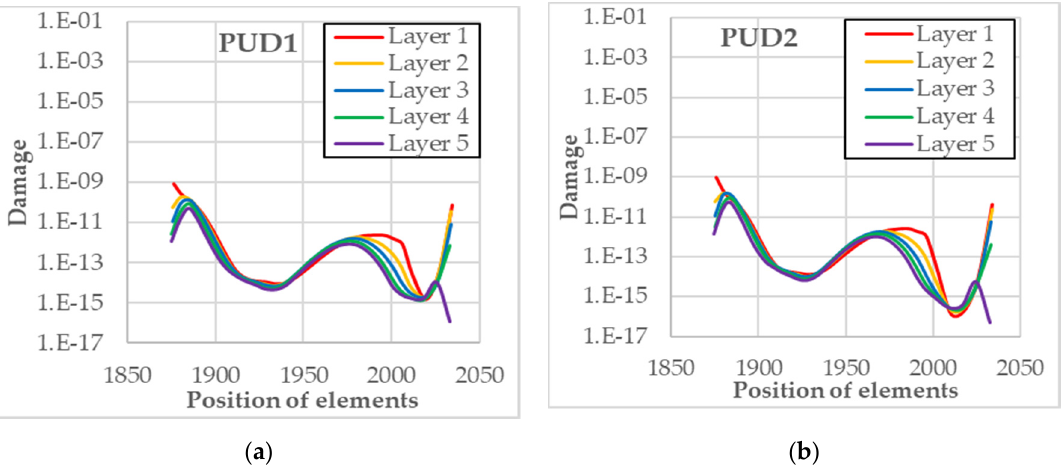
Figure 17. Damage of PUD models: ( a ) Damage of the PUD1 model; ( b ) Damage of the PUD2 model.